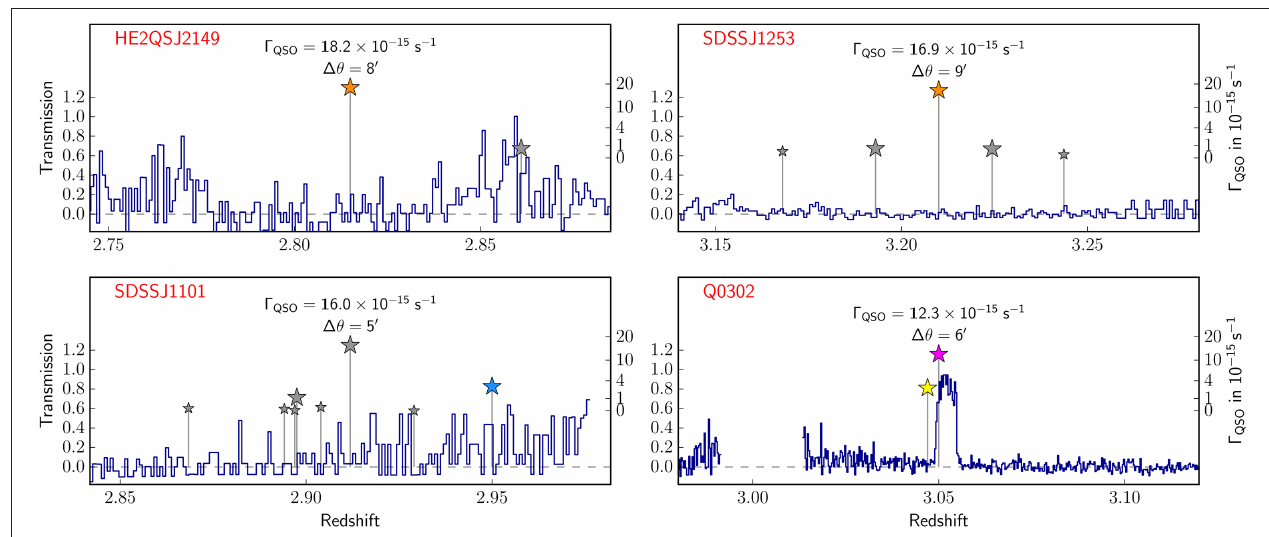
FIGURE 2 | He II spectra in the vicinity of the four foreground quasars with the highest estimated He II ionization rate Ŵ HeII QSO from Schmidt et al. (2017). Colors indicate the origin of the objects. (yellow: VLT/VIMOS; orange: CAHA/TWIN; blue: ESO NTT/EFOSC2; gray: SDSS/BOSS; pink: Literature). Size and vertical displacement of star symbols represent He II ionization rate. Only the previously known quasar along the Q0302 − 003 sightline (Jakobsen et al., 2003) is associated with a strong He II transmission peak. The other three objects show, despite their up to 50% higher He II ionization rate and comparable other properties, extremely low He II transmission along the background sightline. One could speculate that these objects might be either very young or highly obscured toward the background sightline. © : AAS. Figure reproduced from Schmidt et al. (2017).